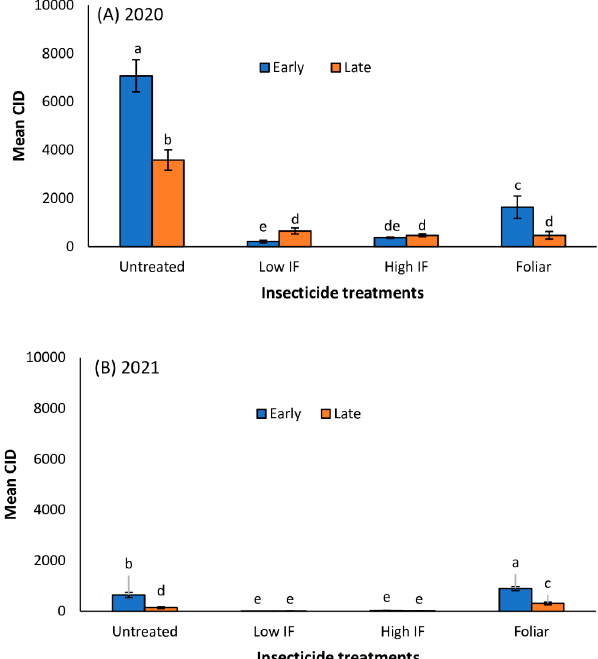
Figure 3. Mean (±SE) cumulative insect days (CID) in early and late planted forage sorghum treated with flupyradifurone in-furrow (IF) or foliar in 2020 ( A ) and 2021 ( B ) in Tifton, GA. Means with different letters are significantly different (sequential Bonferroni test, p < 0.05) among all four insecticide treatments and planting date. Insects 2022 , 13 , x FOR PEER REVIEW